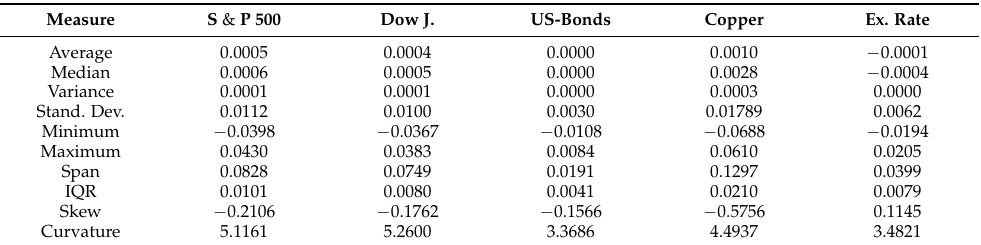
Table 1. Statistical Key Figures of the Data set on a Return Basis. IQR = Interquartile range (0.75- quartiles—0.25-quartiles).